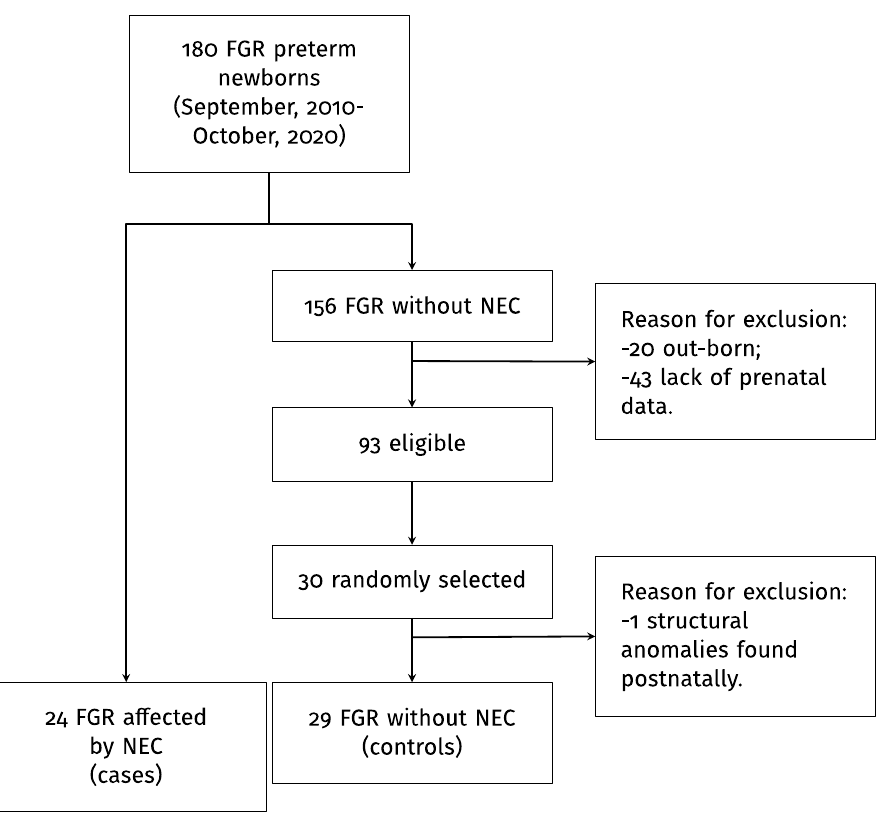
Figure 1. Flowchart. Figure 1.